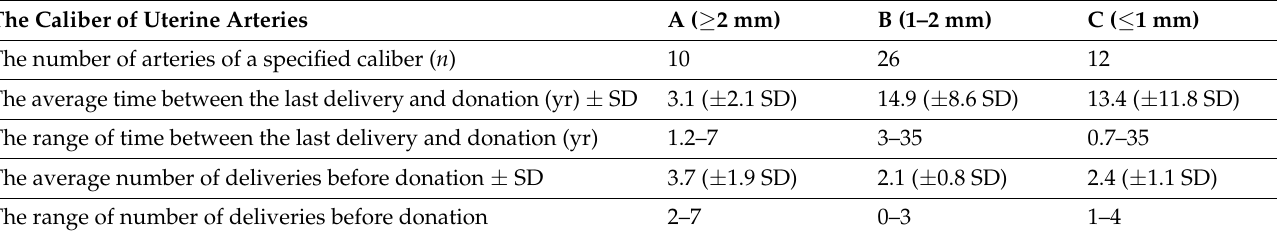
Table 2. Correlation of a caliber of uterine artery on time from the last delivery.